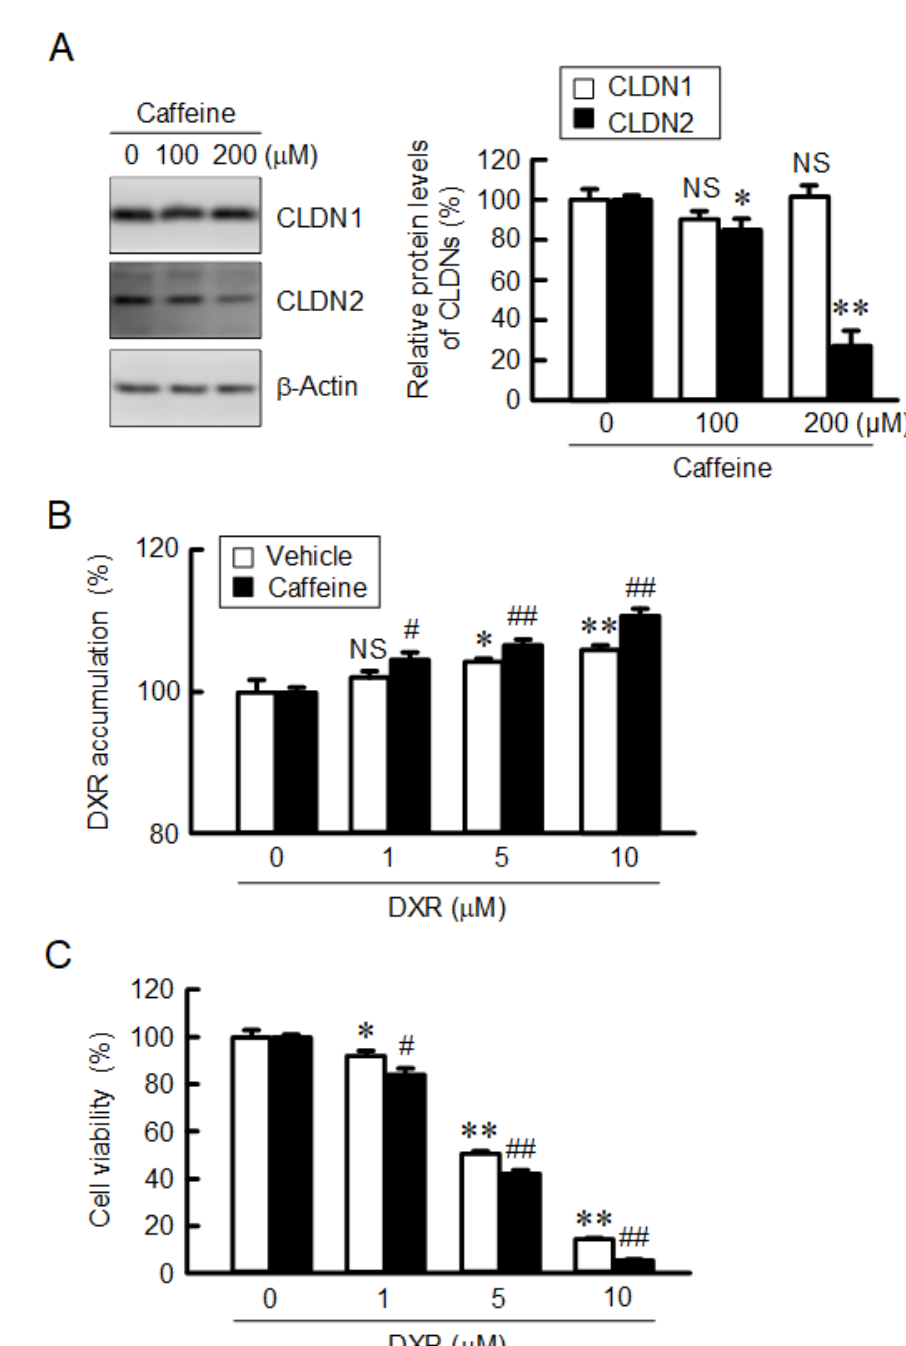
Figure 9. Effect of caffeine on CLDN2 expression and DXR-induced toxicity in RERF-LC-MS cells. ( A ) Cells were incubated with caffeine at the indicated concentrations for 24 h. The expression levels of CLDN1, CLDN2, and β -actin were examined using Western blotting. The protein levels of CLDN1 and CLDN2 are represented as a percentage relative to 0 µ M. ( B ) The spheroids were incubated in the absence (vehicle) or presence of 200 µ M caffeine for 1 h. The fluorescence intensity of DXR is represented as a percentage relative to 0 µ M. ( C ) After incubation of the spheroids in the absence (vehicle) or presence of 200 µ M caffeine for 24 h, followed by incubation with DXR at the indicated concentration. Cell viability is represented as a percentage relative to 0 µ M DXR. n = 3–8. ** p < 0.01, * p < 0.05 and NS p > 0.05 compared with 0 µ M caffeine or DXR. ## p < 0.01 and # p < 0.05 compared with vehicle.